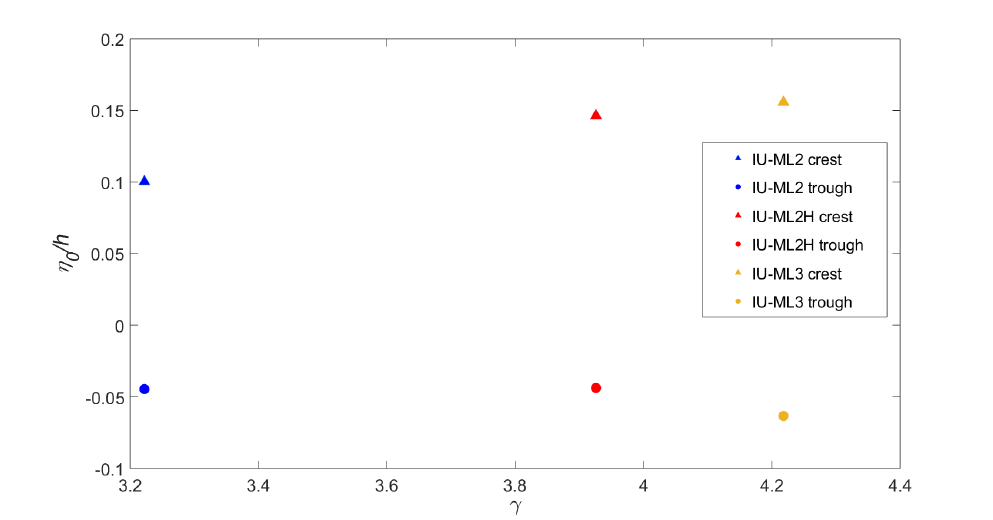
Figure 13. Normalised wave height measured at WG1 for different landslide relative density for cases with an uplift of 60 mm and 370 mm water